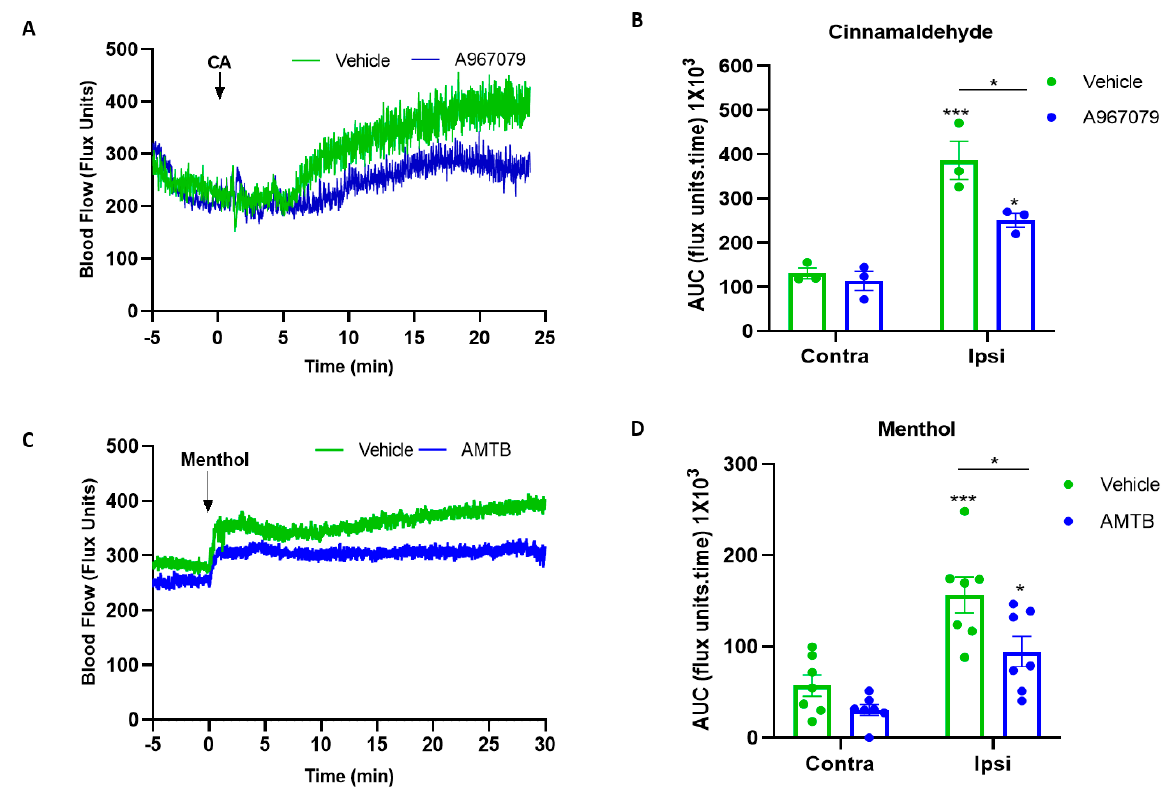
Figure 3. Determining an effective oral dose of the TRP antagonist given in Nutella spread in the CD1 mouse. ( A ) The graph shows the mean blood flow response to the topical application of the TRPA1 agonist cinnamaldehyde (CA, 10%) on the ipsilateral ear in the presence of the TRPA1 antagonist, A967079 (100 mg/kg), given orally 30 min prior to CA application. ( B ) The area under the curve (AUC) analysis of the blood flow increase after vehicle (10% DMSO) or CA treatment in the presence of A967079 ( n = 3). ( C ) The graph shows the mean blood flow response to the topical application of the TRPM8 agonist menthol (10%) on the ipsilateral ear in the presence of the TRPM8 antagonist, AMTB (10 mg/kg), given orally 30 min prior to menthol application. ( D ) The area under the curve (AUC) analysis of the blood flow increase after vehicle (10% DMSO) or menthol treatment in the presence of AMTB ( n = 7). (All the data are shown as mean and error bars indicate S.E.M. * p < 0.05, *** p < 0.001. (Two-way ANOVA, Tukey’s post hoc test).